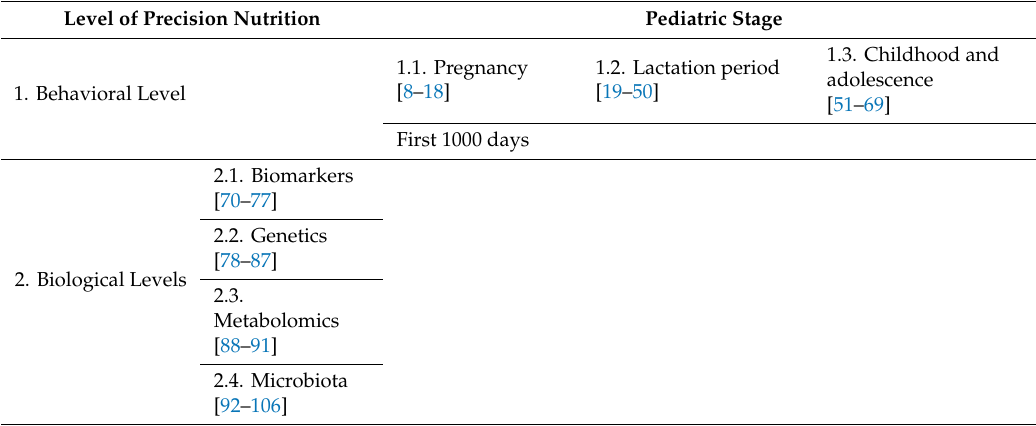
Table 1. Levels of personalization of nutrition-based interventions in the prevention and treatment of obesity throughout the di ff erent pediatric